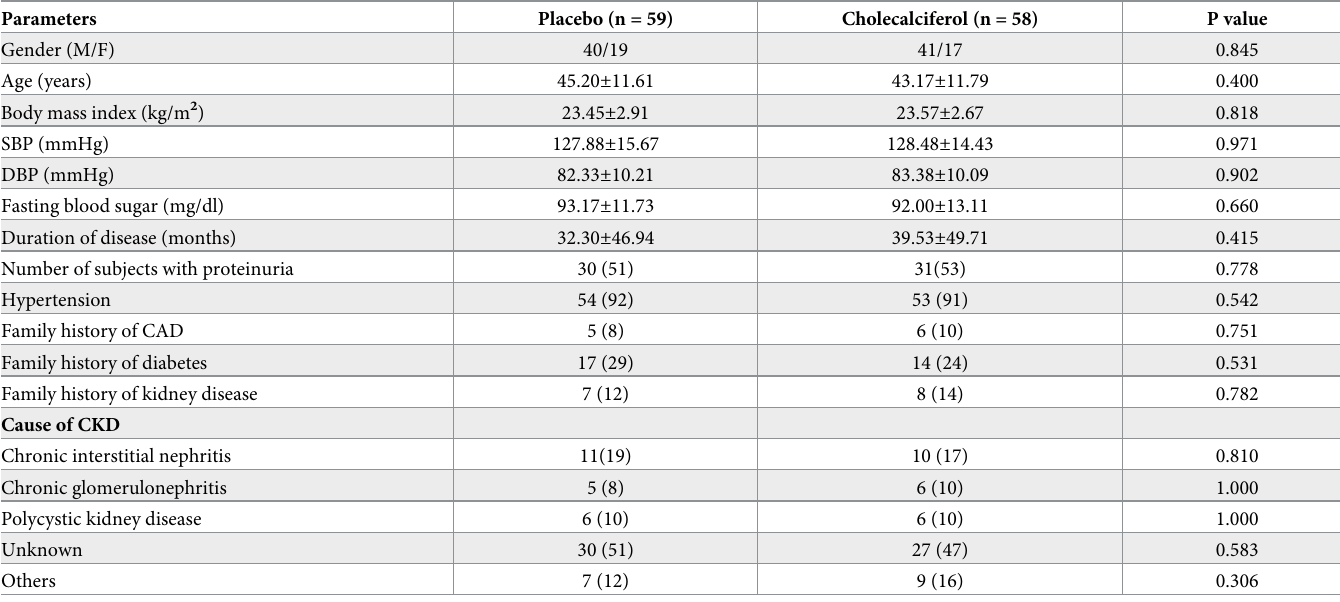
Table 1. Baseline characteristics of study subjects.